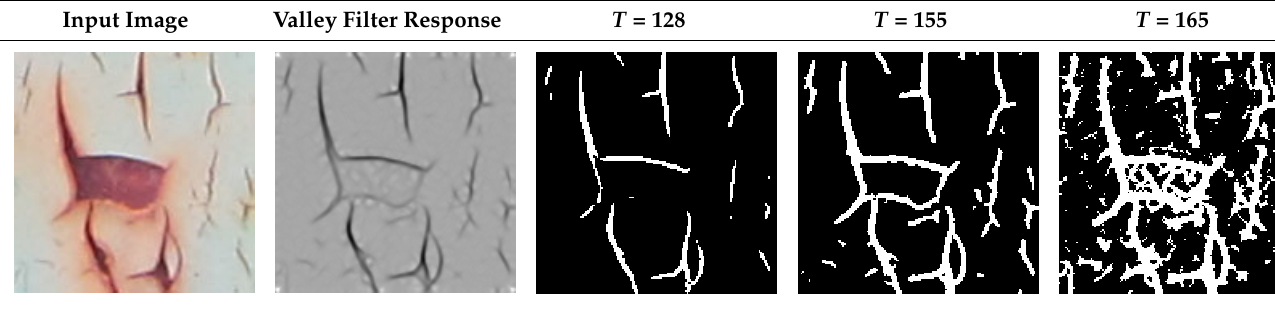
Table 5. Input image segmentation stages.